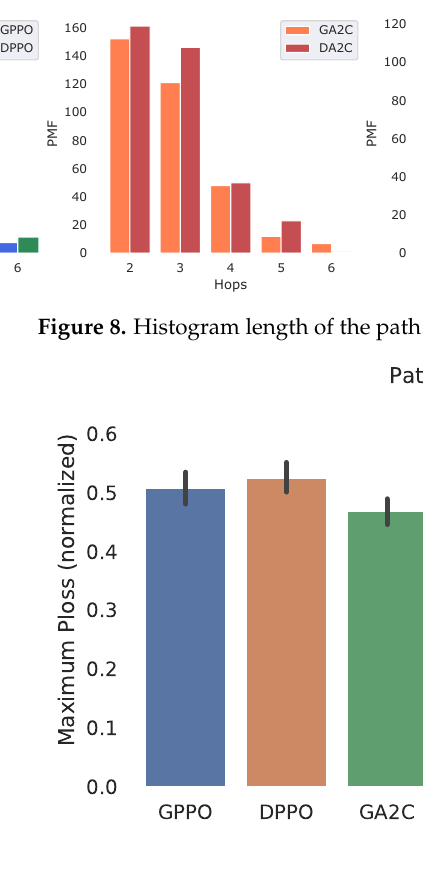
Figure 9. Maximum Path Loss